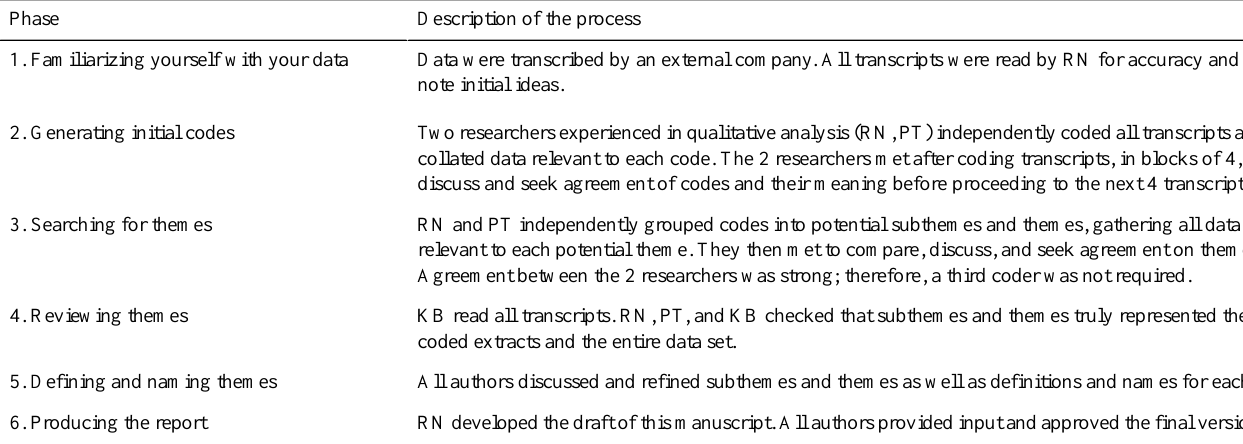
Table 2. Thematic analysis process conducted based on the phases described by Braun and Clarke